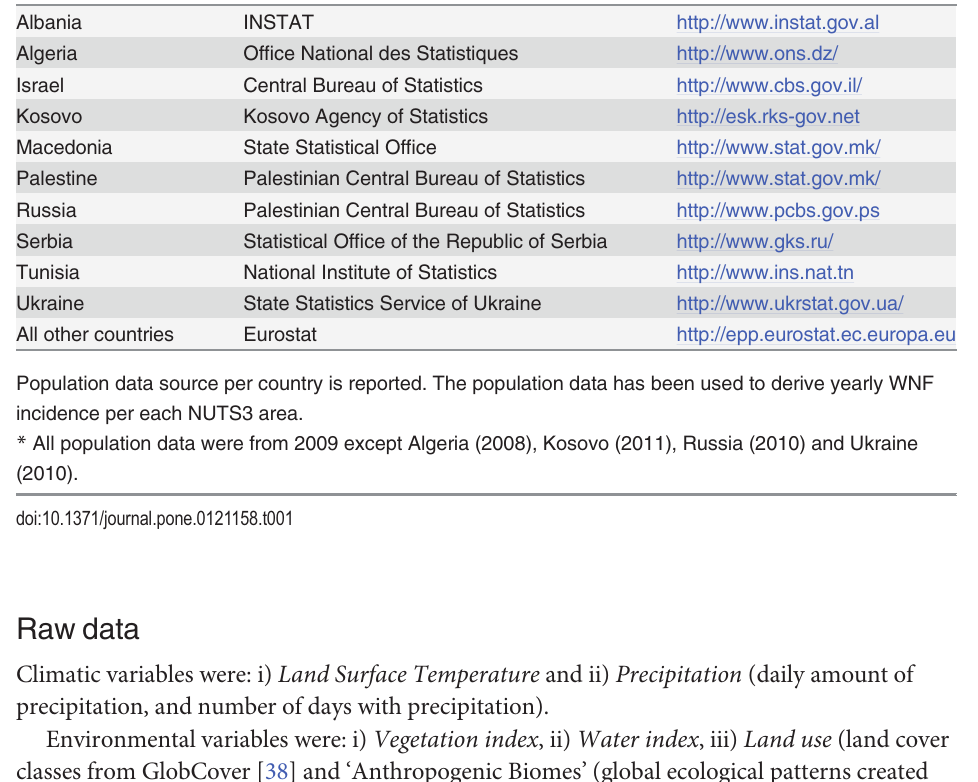
Table 1. Population data. Country